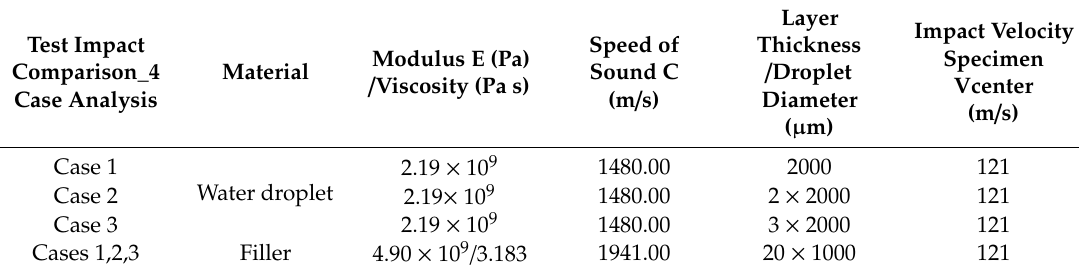
Table 5. Modelling input data for variation cases in droplet diameter and considering semi-infinite substrates, h s > 2d C s C L